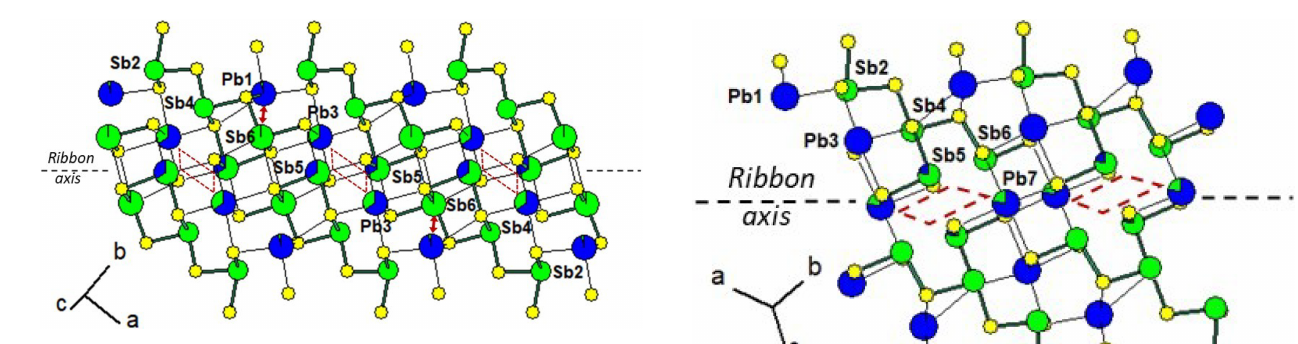
Figure 4. Mixed Pb / Sb sites in the ribbon of the structure of fülöp- pite (sample F2 – see Table 3). Red lozenge: neighbouring (Pb,Sb)3 ( × 2) and (Sb,Pb)5 ( × 2) strongly mixed sites. Red arrow: (Sb,Pb)6 and (Pb,Sb)1 weakly mixed sites. For clarity, mixed sites are unsplit.